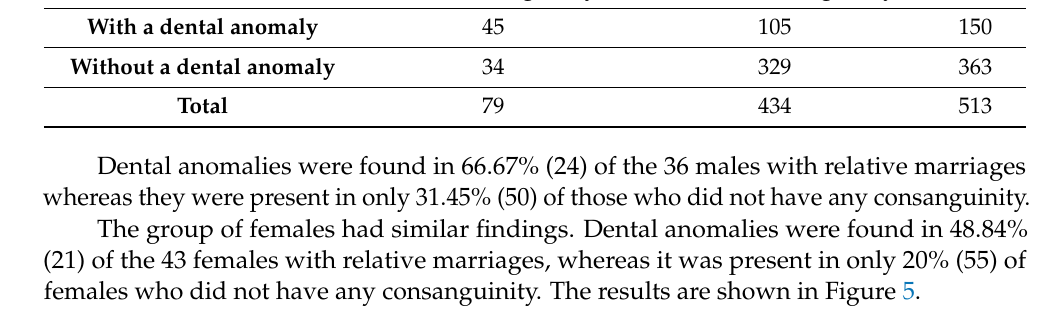
Table 3. The prevalence of dental anomalies by consanguinity groups. With Consanguinity Without Consanguinity Total With a dental anomaly 45 Without a dental anomaly